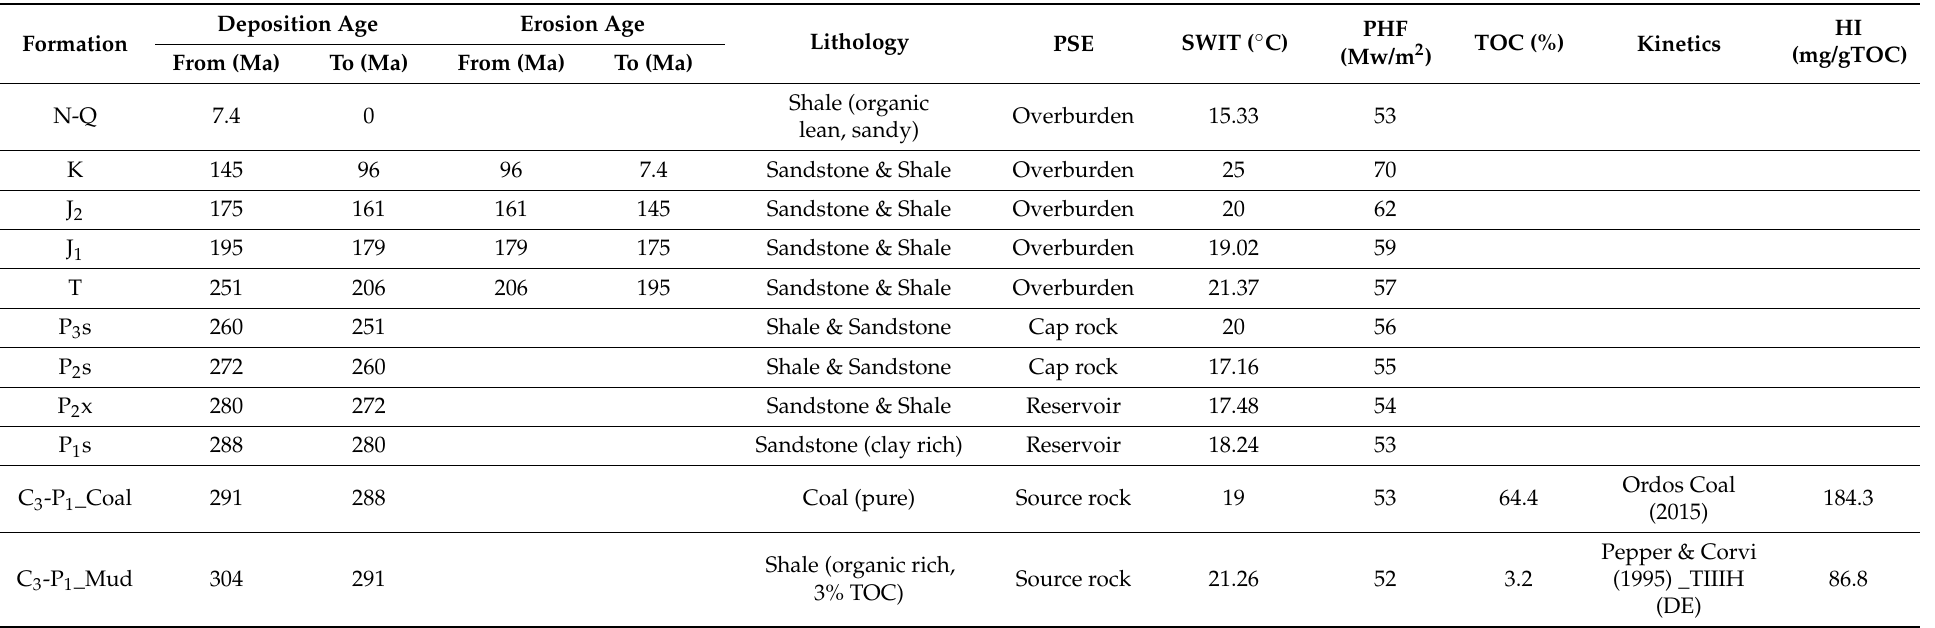
Table 1. Input parameters for 1D basin modeling. SWIT: Sediment-water-interface temperatures. PHF: Paleo-heat flow. HI: Hydrogen index. The “Ordos coal (2015)” kinetics was referenced from Liu et al. (2016)